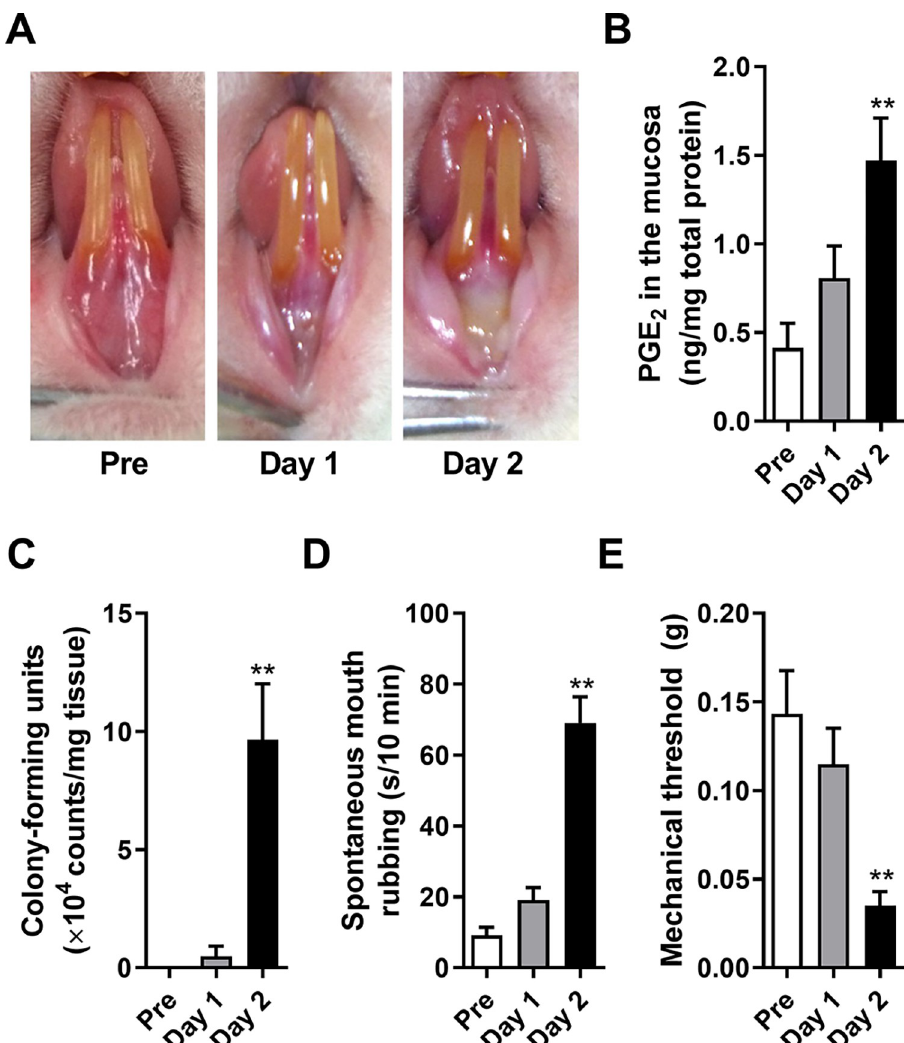
Fig 1. Development of oral ulcerative mucositis and pain induction following acetic acid treatment. (A) The visual appearance of the oral mucosa before the treatment (Pre) and on day 1 and day 2 after treatment with a 50% acetic acid-soaked filter paper (3 × 3 mm, 9 mm 2 ) for 30 s. (B) Prostaglandin E 2 (PGE 2 ) production in the oral mucosa (n = 9 in each group). (C) Counts of colony-forming units (CFUs) under anaerobic conditions (n = 4 in each group). (D) Spontaneous mouth rubbing time for 10 min before (Pre) and on day 1 and day 2 after the acetic acid treatment (n = 5 in each group). (E) Head withdrawal threshold in response to the application of von Frey filaments to the oral mucosa before (Pre) and on day 1 and day 2 after the acetic acid treatment (n = 6 in each group). All bars represent the mean ± SEM. ** p < 0.01 compared with Pre, Dunnett’s post hoc test following one-way ANOVA (B, C and D) and Friedman and Dunn’s post hoc tests